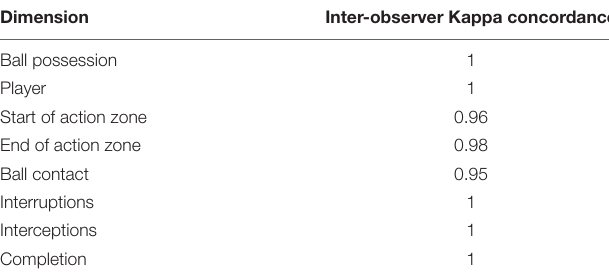
TABLE 3 | Kappa concordance results of the different intra-observer and inter-observer dimensions.